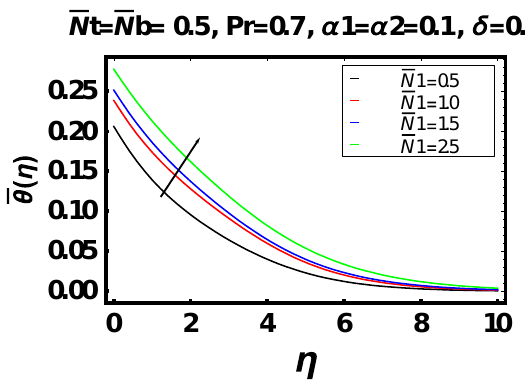
Figure 10. Temperature profile for variant N̅ 1 .